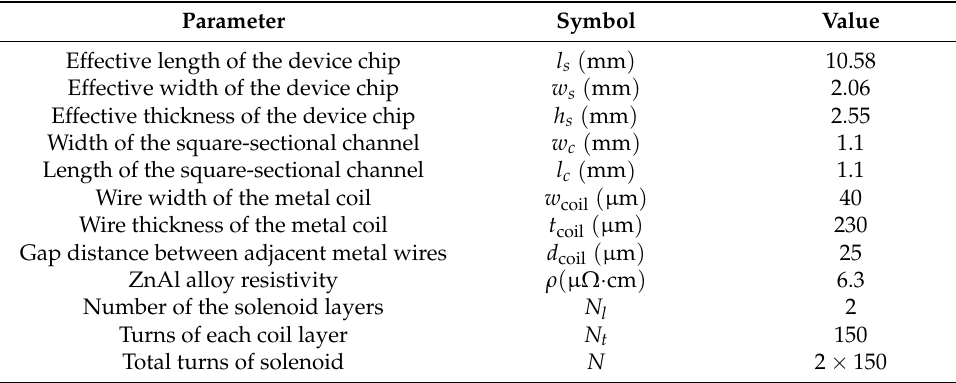
Table 2. Material and geometric parameters of the solenoid.